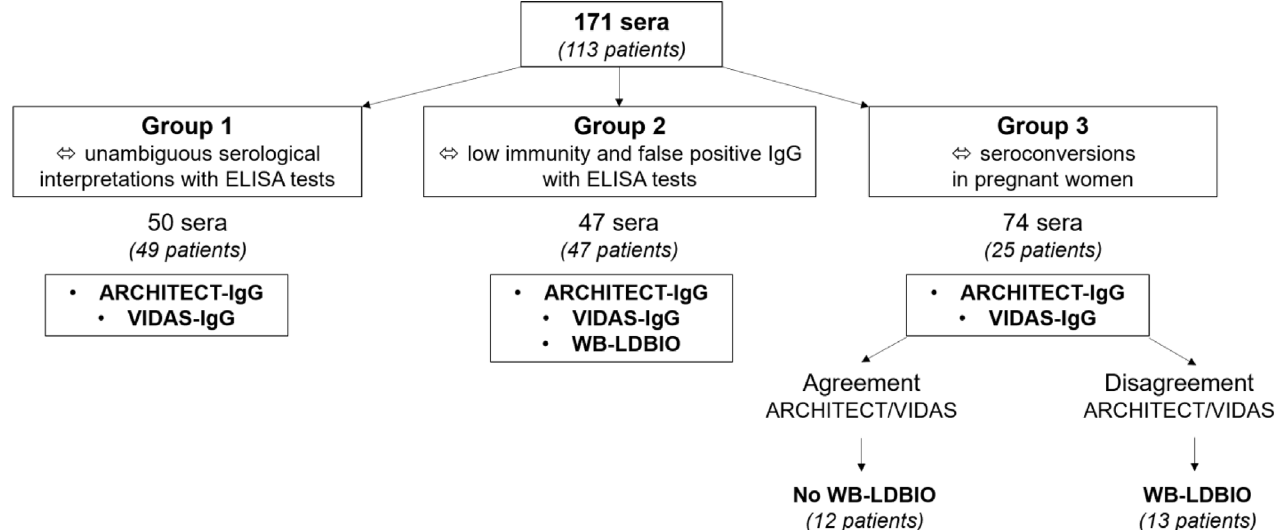
Figure 1. Classi fi cation of sera into three groups and IgG detection techniques performed on each category of